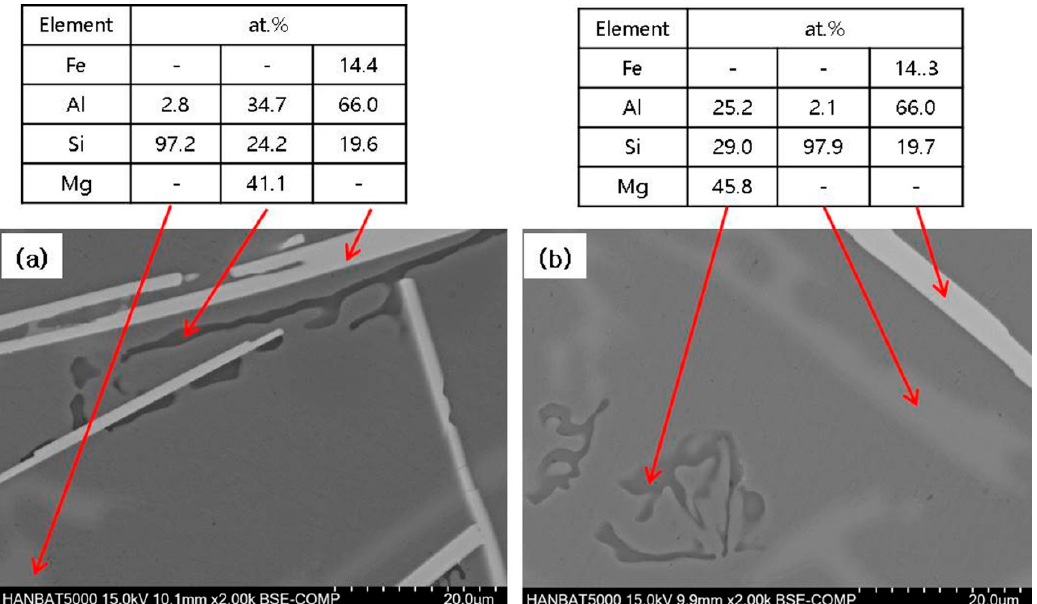
Figure 10. SEM-EDS analysis of cast iron / liquid Al–Si alloy interface isothermally heated at 720 ◦ C for